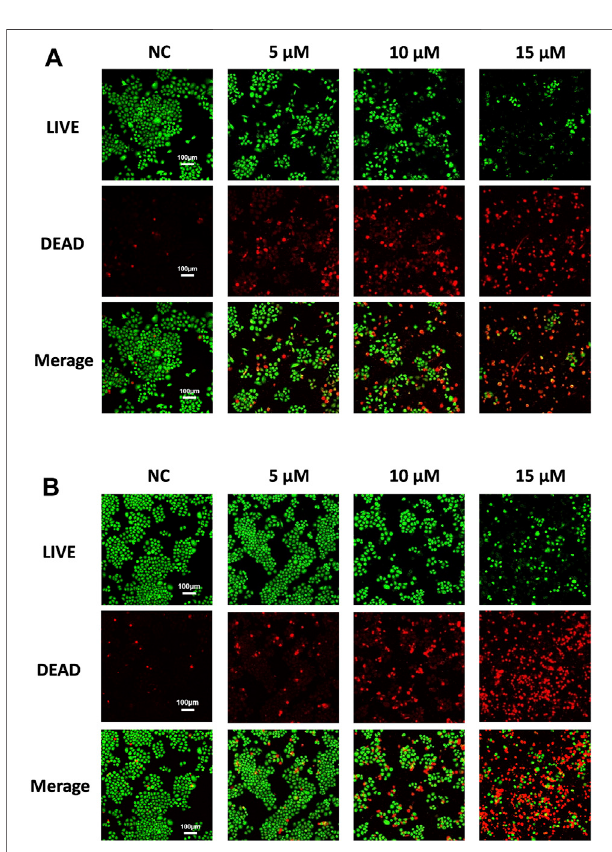
FIGURE 3 | Compound d17 suppresses H460 and A549 cancer cells. Fluorescence images of (A) H460 and (B) A549 cells exposed to compound d17 with indicated concentrations for 48 h and then stained with the red/ green kit; green indicates live cells, and red indicates dead cells.